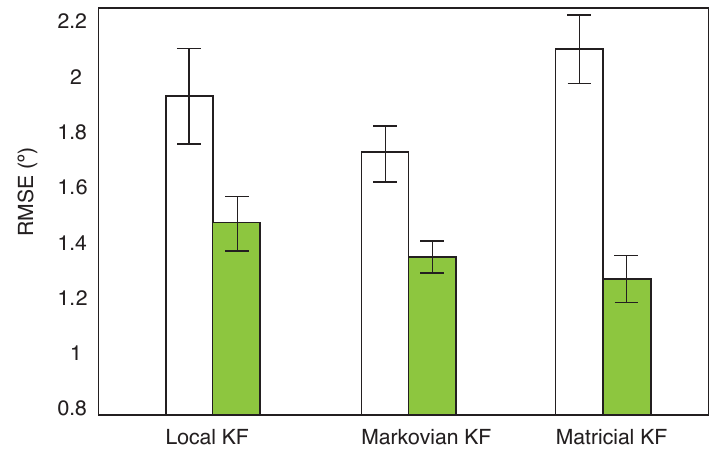
Figure 9. Interaction between the Kalman Filter and calibration for the trunk segment. The complex calibration is displayed in green. The bars represent the 95% confidence